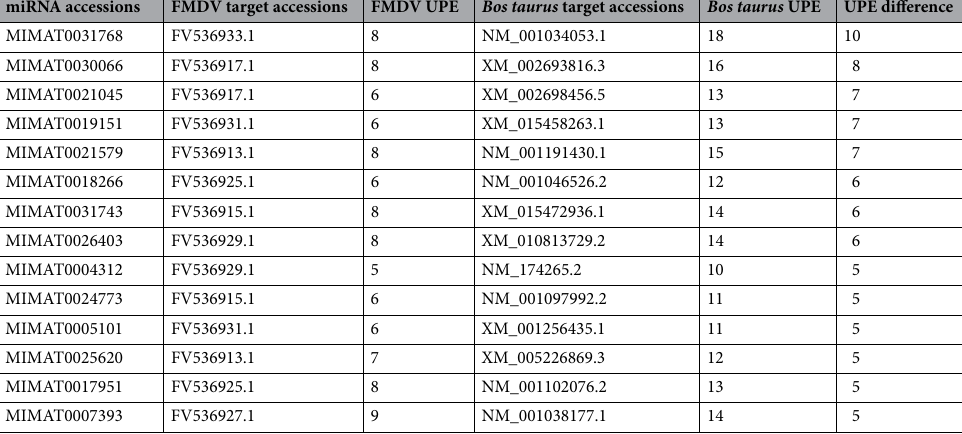
Table 3. miRNA accessions for which the UPE for FMDV targets is at least 5 units lower than that of Bos taurus targets.